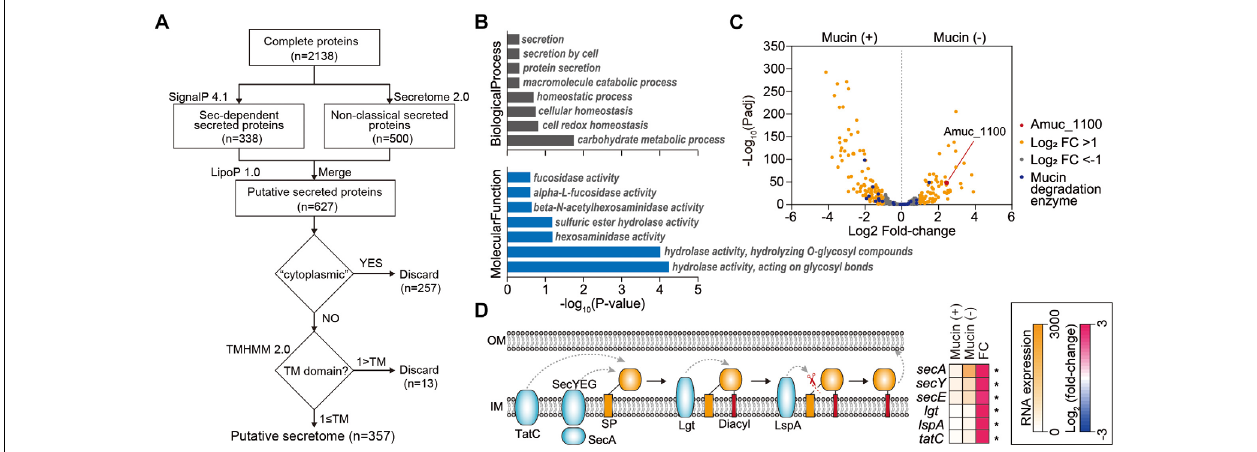
FIGURE 3 | Analysis of extracellular proteins and protein secretion systems in A. muciniphila . (A) Workflow to identify the extracellular proteins encoded in A. muciniphila genome. (B) Significantly enriched Gene Ontology (GO) terms among the predicted extracellular proteins. GO terms belonging to the biological process and molecular function categories are shown in gray and blue, respectively. (C) Volcano plots summarizing the differentially expressed genes encoding extracellular proteins. The negative log 10 of the Padj is plotted on the Y-axis, and the log 2 of the fold change is plotted on the X-axis. (D) Differentially expressed genes involved in protein secretion pathways in A. muciniphila . ∗ Padj <